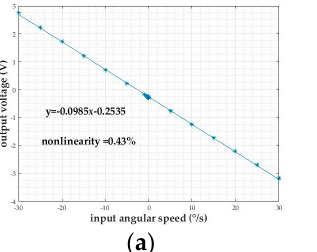
Figure 12. ( a ) photograph of the rate table with the proposed rotational gyroscope and a Micro-electromechanical Systems (MEMS) quartz vibratory gyroscope on it for dynamic characteristic test; ( b ) impulse responses of the proposed rotational gyroscope and a MEMS quartz vibratory gyroscope.